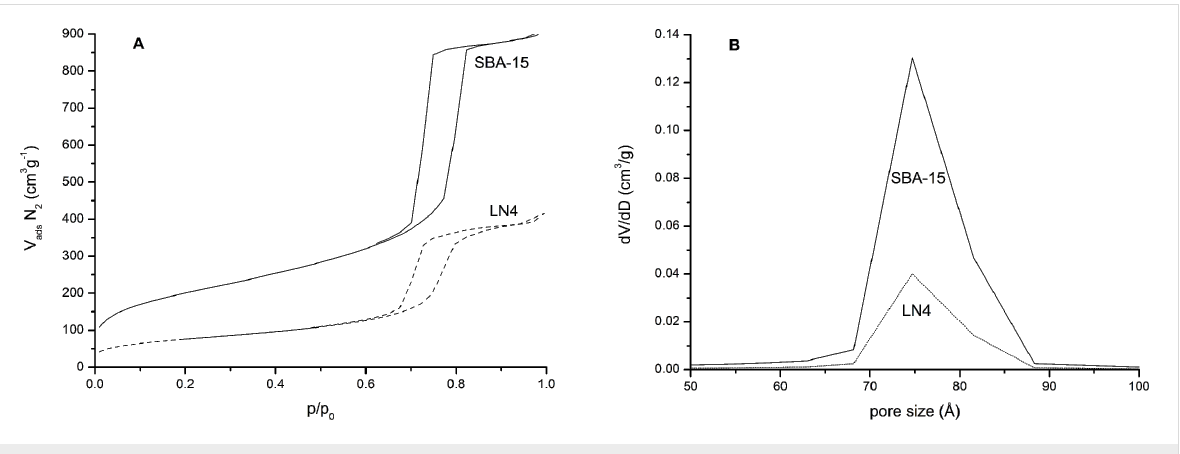
Figure 2: N 2 adsorption and desorption isotherms (77 K) of SBA-15 and as-prepared LiNbO 3 /SBA-15 composite (A) and the corresponding pore size distributions of the samples.